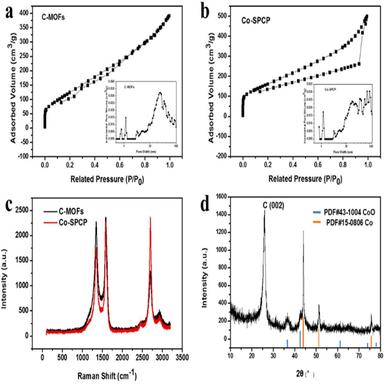
N2 sorption isotherms of the C-MOFs and Co-SPCP (a and b) with the insert of pore size distribution based on the DFT method, Raman spectra of the C-MOFs and Co-SPCP samples (c), XPD patterns of Co-SPCP (d).